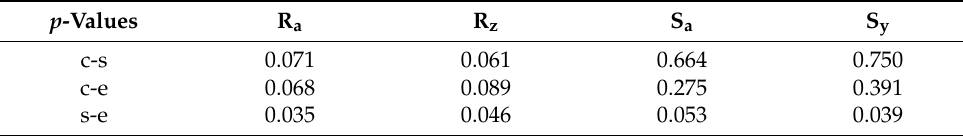
Table 2. p -Values related to conditioning method, after conditioning. p -Values